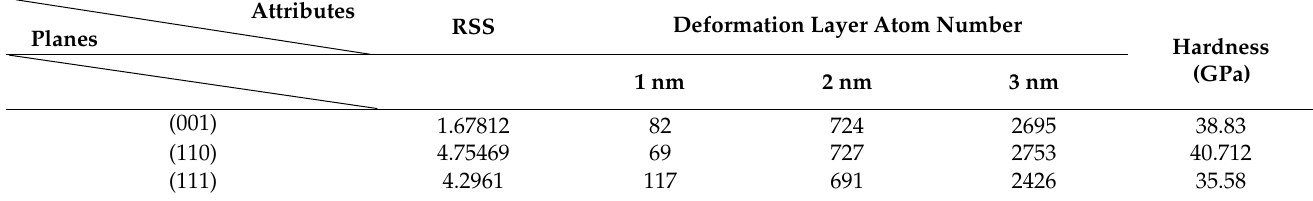
Table 1. Deformation layer data of crystal plane loading